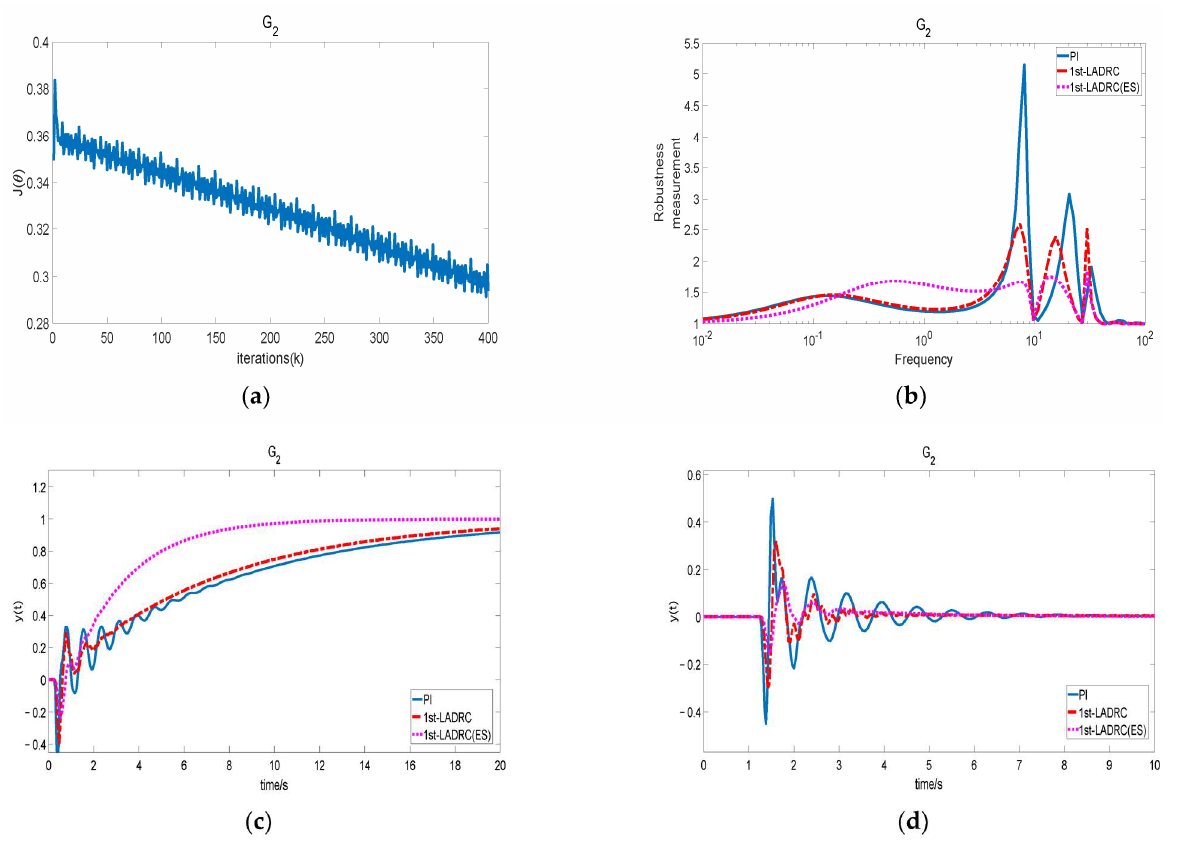
Figure 8. ( a ) Evolution of the cost function; ( b ) robustness of controllers; ( c ) output signal; ( d ) disturbance responses during experiments of a closed-loop system with G 2